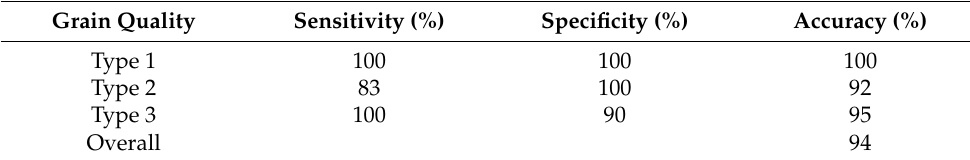
Figure 3. Results of k-value optimization. Error bars represent the standard deviations of five training prediction measurements. Table 3. Classification metrics of optimized k-NN